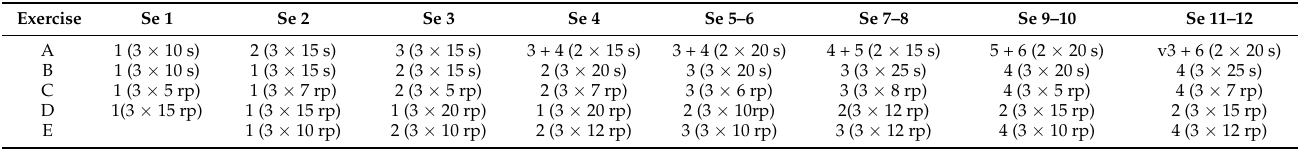
Table 2. Progressive training program for intervention group.